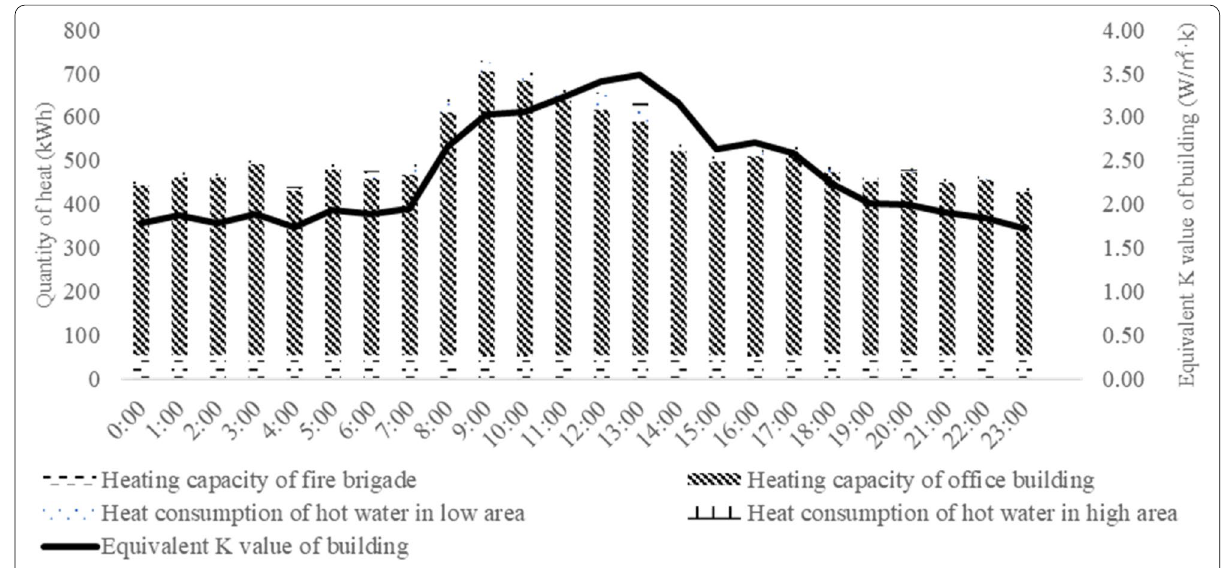
Fig. 6 Test of typical daily heat conditions of buildings during severe cold